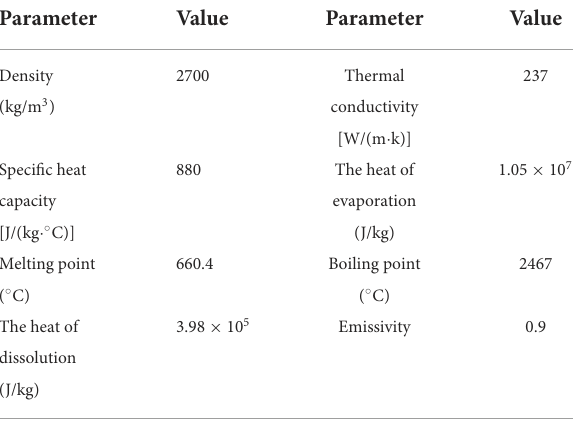
TABLE 4 Main property parameters of aluminum